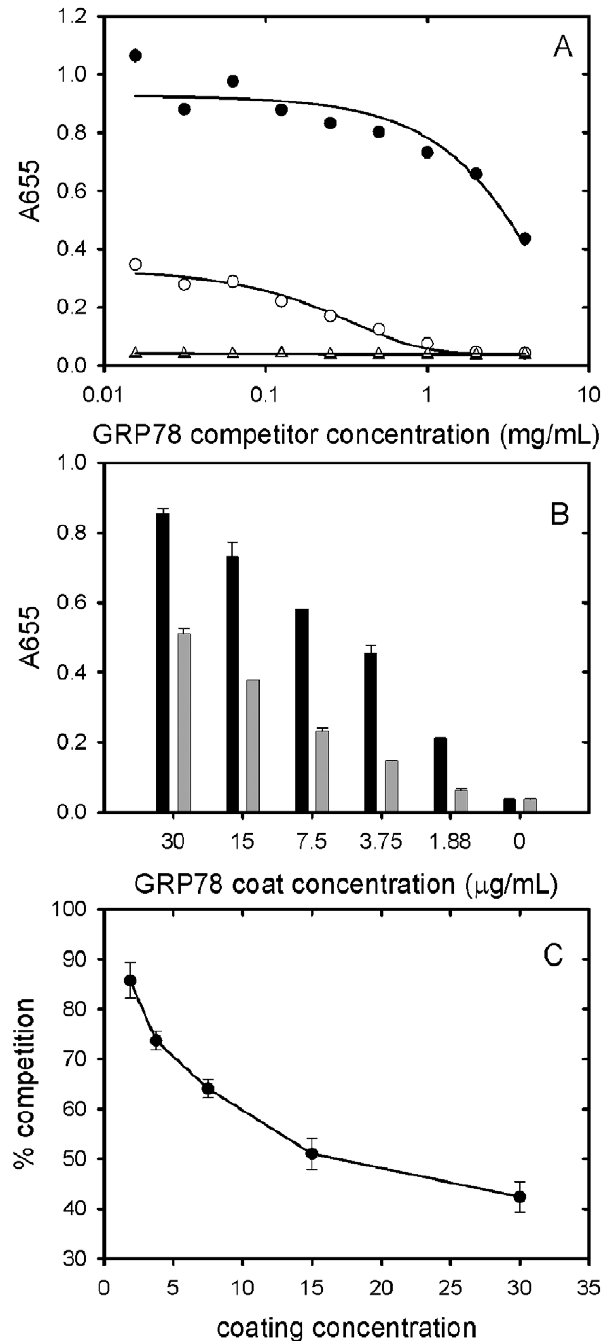
Figure 9. Competition ELISA data obtained using soluble GRP78 as a competitor. A. The concentration of GRP78 used to coat the wells was 7.5 m g/mL. The primary antibodies used were PAT- SM6 (5 m g/ml, closed circles) and polyclonal anti-GRP78 (open circles). Results are also presented for control experiments omitting GRP78 coat using as primary antibodies PAT-SM6 (5 mg/ml, closed triangles) or anti-GRP78 (open squares). B: The binding of PAT-SM6 (5 m g/ml) to immobilized GRP78 at different GRP78 coating concentrations in the absence (black bars) or presence (grey bars) of soluble GRP78 (4 mg/ ml). C: Soluble GRP78-induced inhibition of PAT-SM6 binding to immobilised GRP78 at different GRP78 coating concentrations. The concentrations of PAT-SM6 and soluble GRP78 used were 5 m g/ml and 4 mg/ml respectively.